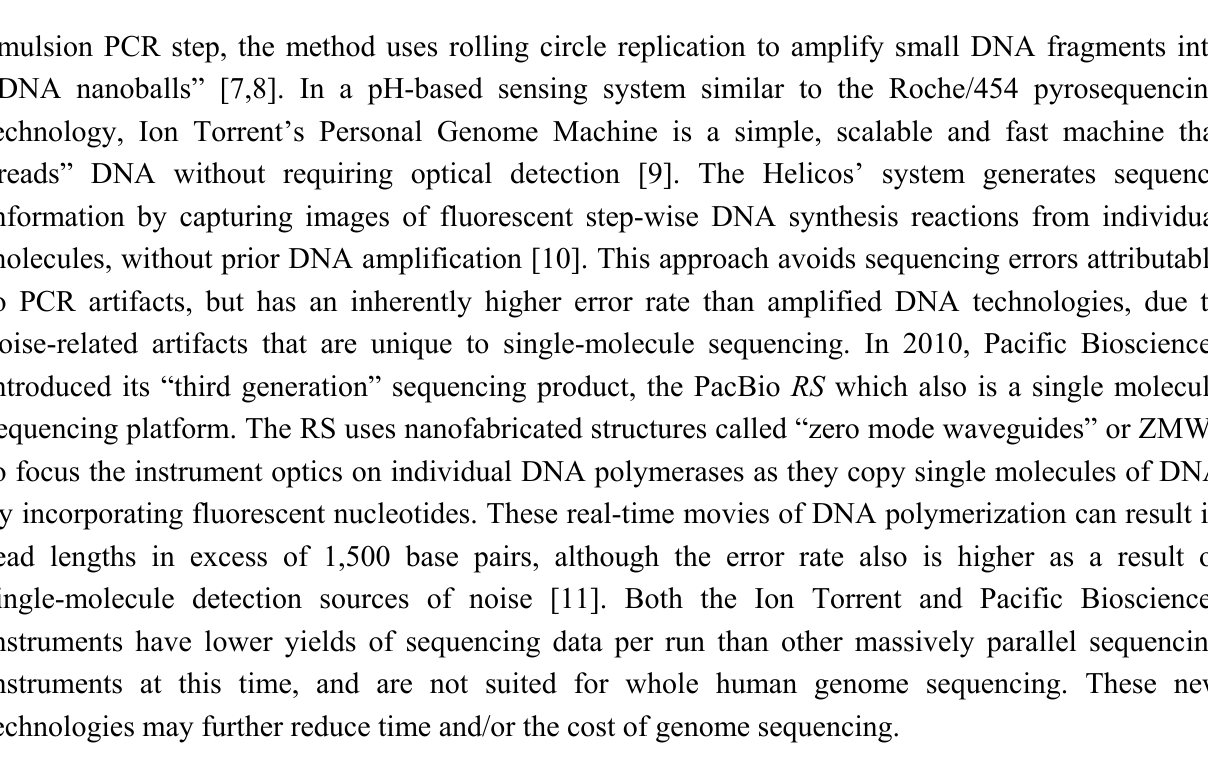
Table 1. Summary of DNA sequencing platforms 1